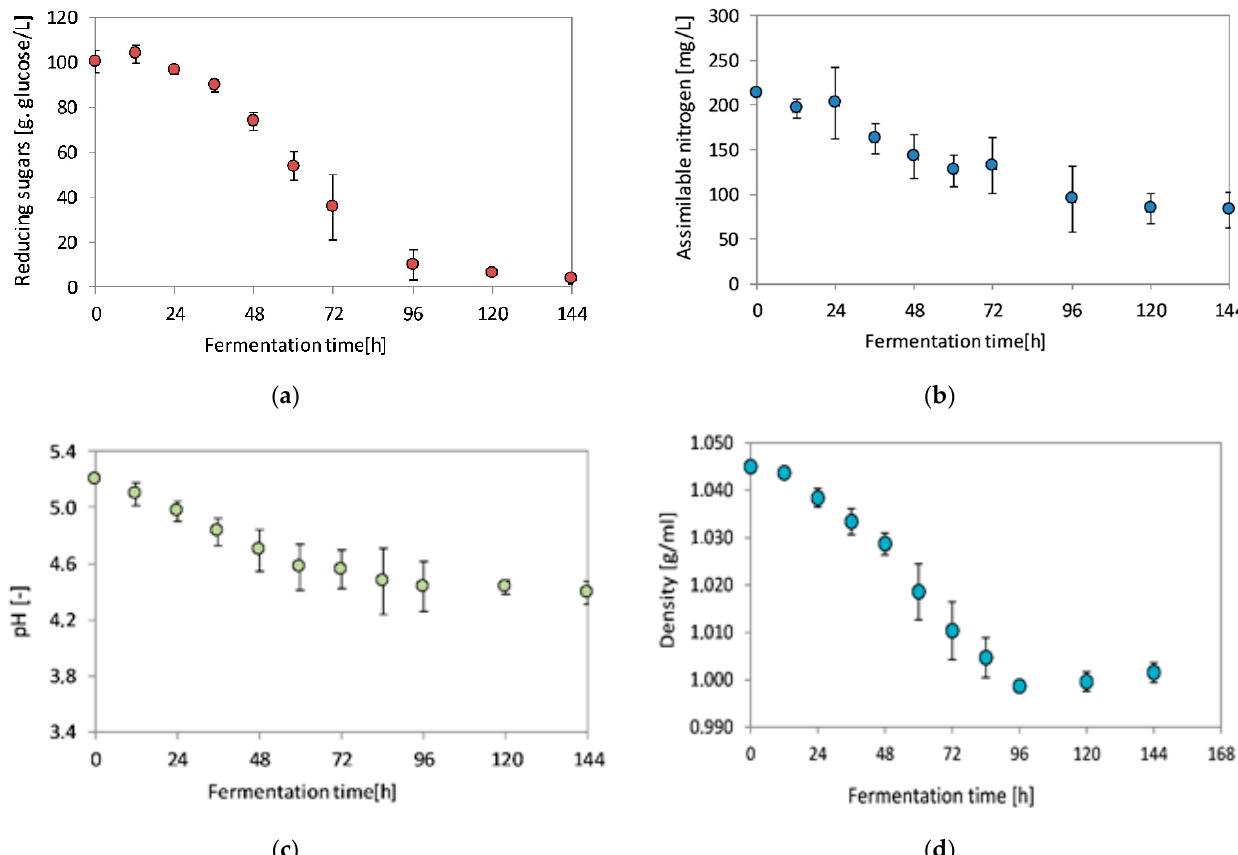
Figure 2. Evolution of: ( a ) reducing sugars, ( b ) yeast assimilable nitrogen, ( c ) pH and ( d ) density during the fermentation of piñon wort n = 3. Table 4. Average results (with standard deviation) of different parameters before and after